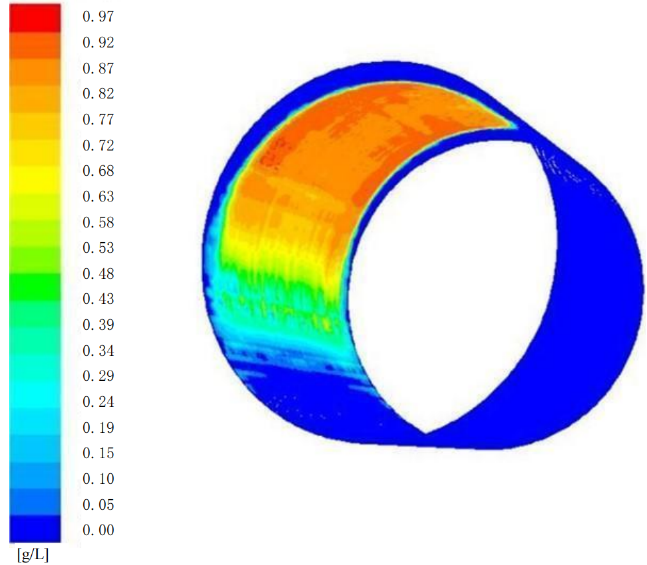
Figure 4. Gas phase volume fraction distribution considering cavitation effect: Volume fration (g/L).